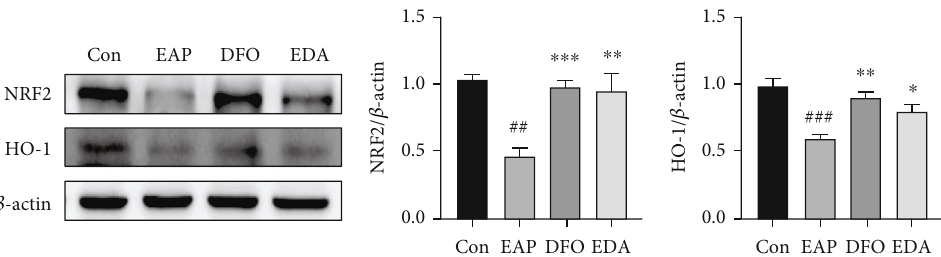
Figure 8: DFO and EDA inhibited EAP-associated ferroptosis through restoring the NRF2/HO-1 pathway. Western blot analysis was applied to assess the protein expression of the NRF2/HO-1 axis. ## P < 0 : 01 versus control group; ### P < 0 : 001 versus the control group; ∗ P < 0 : 05 versus the EAP group; ∗∗ P < 0 : 01 versus the EAP group; ∗∗∗ P < 0 : 001 versus the EAP group.